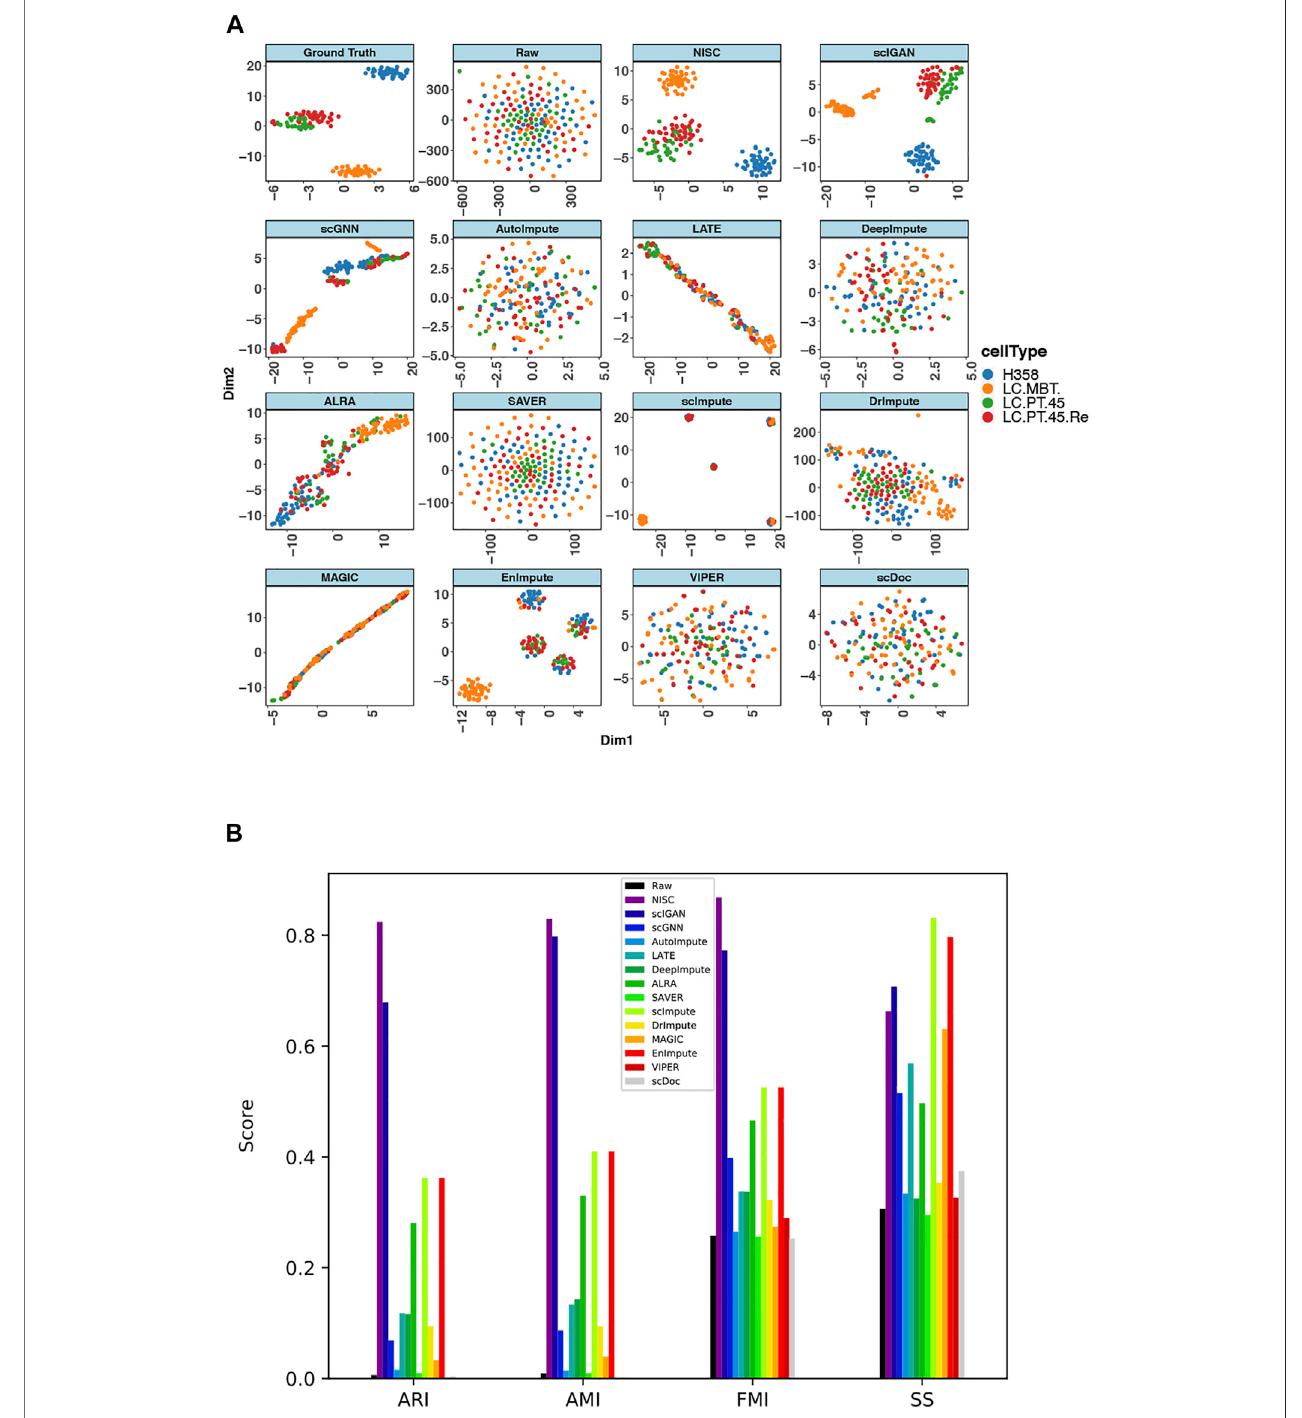
FIGURE 8 | NISC recovers the cell types in lung adenocarcinoma data (GSE69405) (A) plots of t-SNE components 1 and 2 derived from raw data, imputed data using NISC and other imputation methods. With additional zeros the sparsity of the data is 80%. Cells are colored by cell types, which are reported in the original publication (B) Bar plots of evaluation of cluster accuracy on the raw and imputed data. Four measurements, AMI, ARI, FMI, and SS, are calculated for the imputed and raw data. The de fi nitions of the measurements can be found in the supplementary.